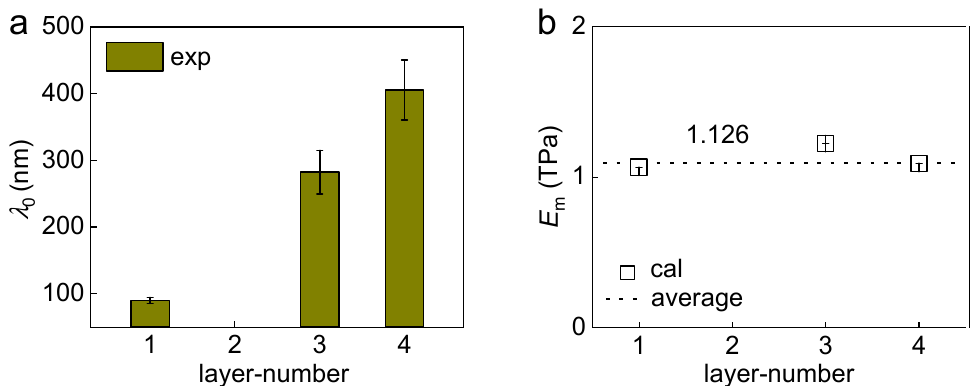
Figure 3. Statistical results for the surface perimeter and modulus of few-layer graphene. ( a ) The surface perimeter of wrinkles in few-layer graphene. ( b ) Calculated Young’s modulus, E m , of few- layer graphene.